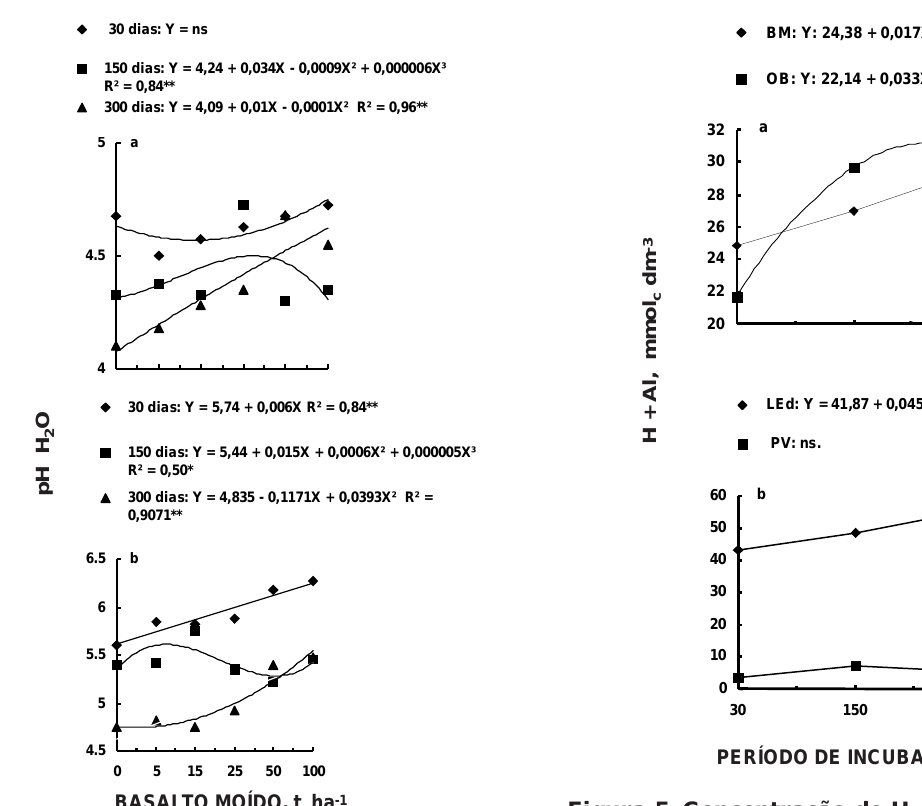
Figura 5. Concentração de H + Al no solo, após 30, 150 e 300 dias de incubação. a: Média de dose e solo para o basalto microcristalino (BM) e para olivina-basalto (OB). b: Média de dose e rocha para o Latossolo Vermelho-Escuro (LEd) e para o Podzólico Vermelho-Amarelo